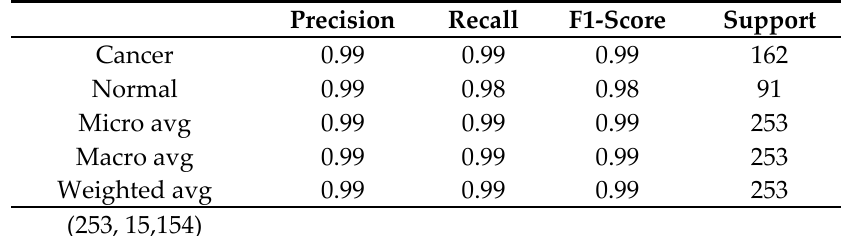
Table 6. Classification Results for Support Vector Machine (SVM).